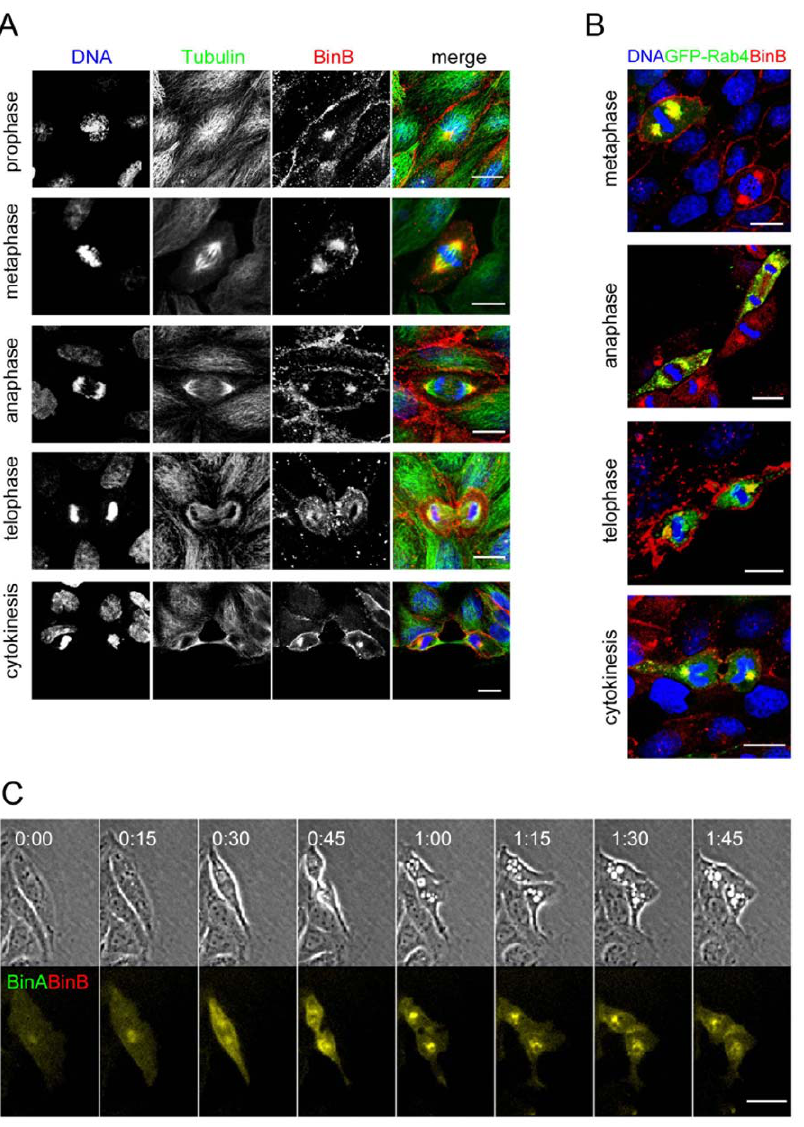
Figure 7. Fate of internalized toxin in dividing cells. (A) Immunodetection of b -tubulin and DNA staining were performed in MDCK-Cpm1 cells treated with unlabelled BinA and BinB-Al 543 for 6 hours. (B) Cells were transfected with GFP-Rab4 then intoxicated as described above, fixed, and stained for DNA. Cells in the process of cell division were analyzed for the localization of the toxin. (C) Time lapse videomicroscopy analysis was performed on MDCK-Cpm1 cells treated with BinA-Al 488 and BinB-Al 543 for 24 h. The panel selected from video S4 shows a cell displaying post-mitotic vacuolation, the selection starts 16 hours after intoxication. While the cell was progressing through mitosis, internalized toxins were colocalized and partitioned in the daughter cells. Bars, 10 m